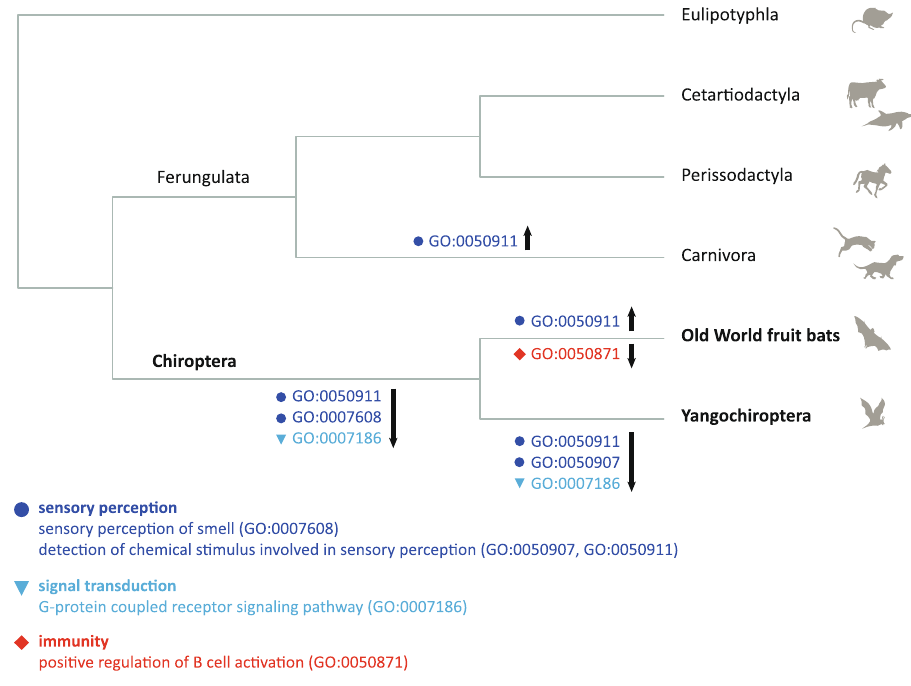
Figure 2. Significant GO terms associated with expanded and contracted HOGs in bats and other laurasiatherians (Ontology: Biological Process; Bonferroni corrected p-value < 0.05). Arrows indicate expansion (upward) and contraction